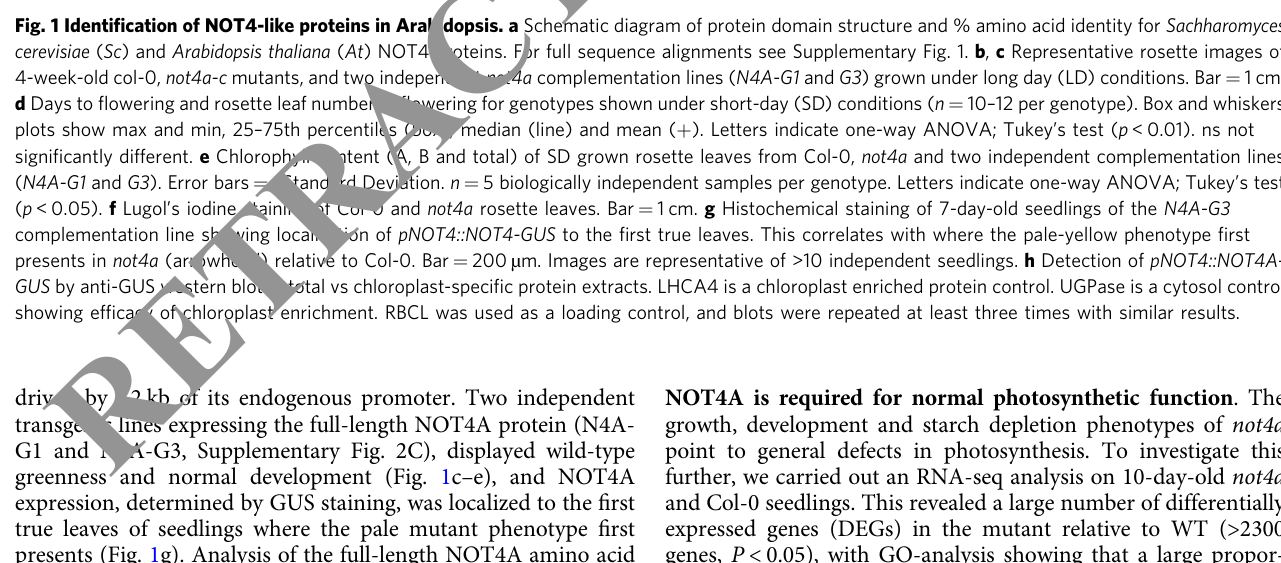
transgenic lines expressing the full-length NOT4A protein (N4A- G1 and N4A-G3, Supplementary Fig. 2C), displayed wild-type greenness and normal development (Fig. 1c – e), and NOT4A expression, determined by GUS staining, was localized to the fi rst true leaves of seedlings where the pale mutant phenotype fi rst presents (Fig. 1g). Analysis of the full-length NOT4A amino acid sequence using TargetP 34 revealed no obvious chloroplast transit peptide (cTP). In accordance with this prediction, anti-GUS western blotting of total vs chloroplast-speci fi c protein extracts indeed revealed that NOT4A is not associated with this organelle, which is also in-line with the reported absence of the ubiquitin proteasome system in plastids (Fig. 1h).